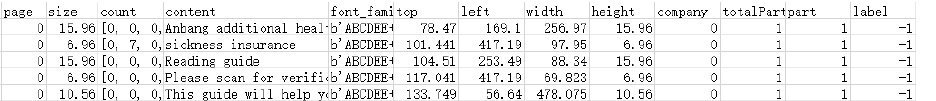
Figure 2. The file format in the data pre-processing step. We modify the Pdfplumber algorithm framework for PDF document information conversion, which can get more features in document content. The features mainly include size, font family, top, company, etc. The features named top, left, width, and height mean distance from page top, distance from page left, total width, and the total height of the sentence, respectively.